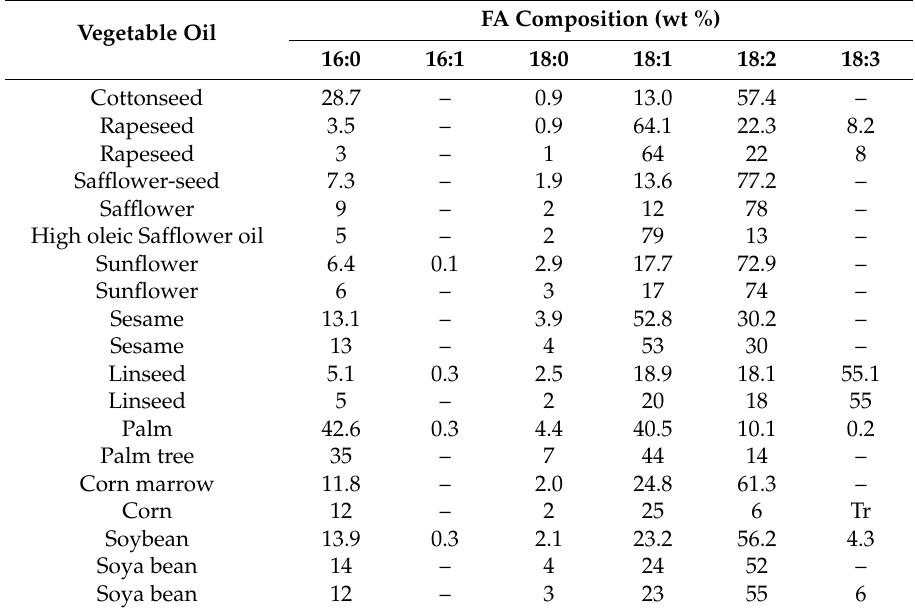
Table 2. Fatty acid (FA) composition of oil